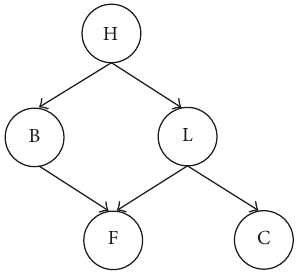
Figure 2: A typical Bayesian network